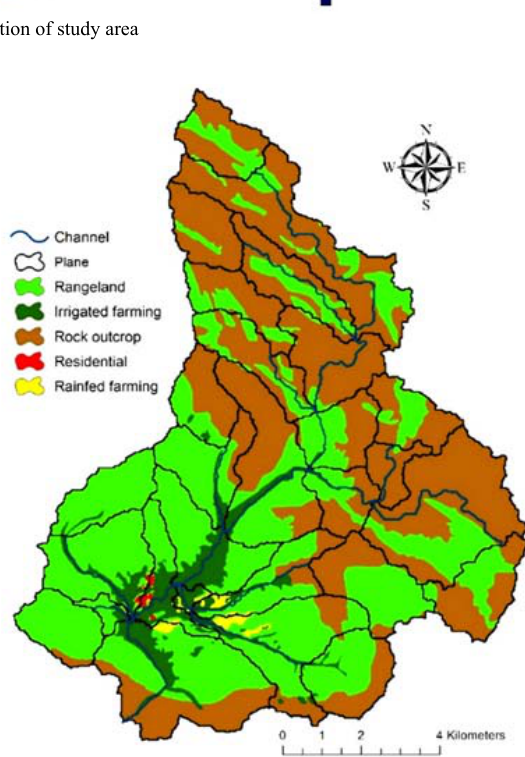
Fig. 2: Land use map of Bar watershed